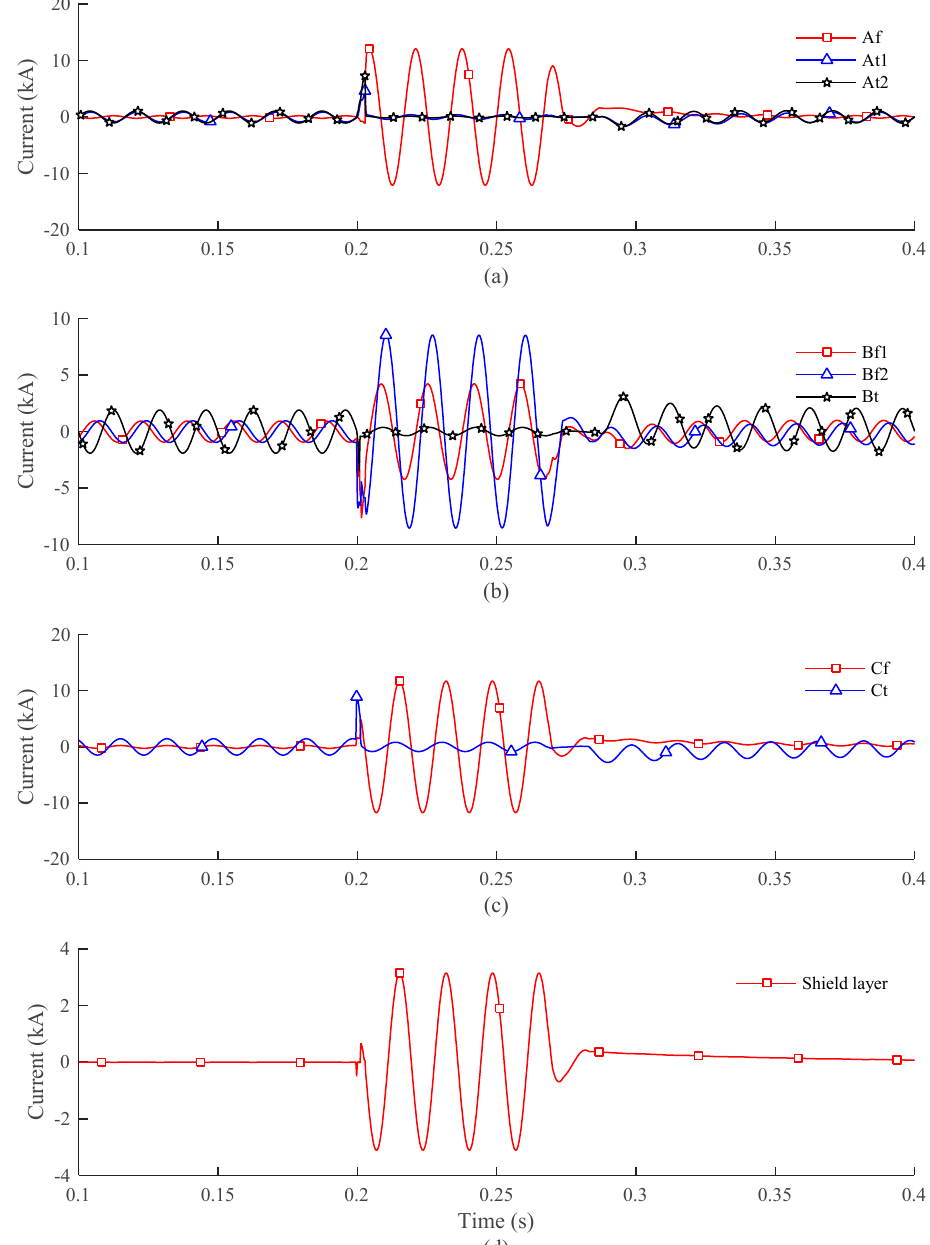
Figure 10. Current distribution in each phase of the HTS cable: ( a ) current in phase A that consists of one former layer ( Af ) and two HTS tape layers ( At 1 and At 2 ); ( b ) current in phase B that consists of two former layers ( Bf 1 and Bf 2 ) and one HTS tape layer ( Bt ); ( c ) current in phase C that consists of one former layer ( Cf ) and one HTS tape layer ( Ct ); and ( d ) current in the shield